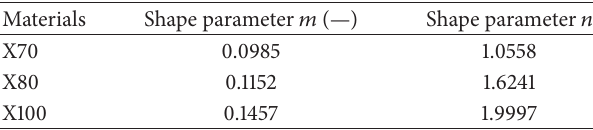
Table 3: Weibull distribution parameters for pitting corrosion of passive films formed on X70, X80, and X100 pipeline steels.